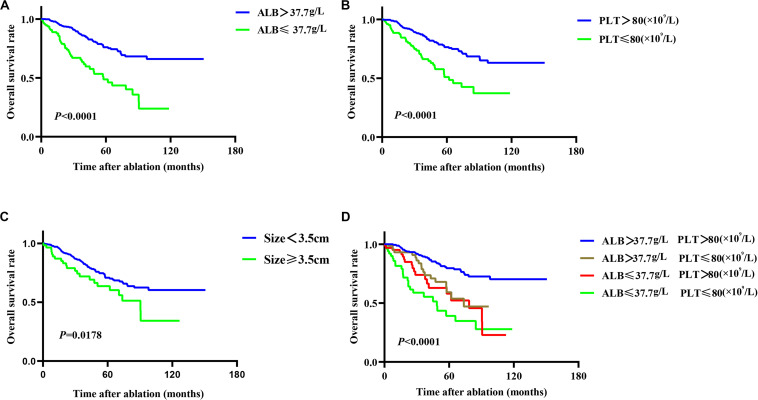
Kaplan–Meier plots for independent prognostic factors of overall survival (OS) in patients with HCC within the Milan Criteria after RFA. (A,B) Patients with reduced albumin (ALB) and platelet (PLT) level had lower OS rate than did those with higher ALB and PLT level. (C) Patients with tumor size ≥3.5 cm had lower OS rate than did those with size <3.5 cm. (D) Different combinations of ALB and PLT showed the different median OS, but the OS of the two combinations of (ALB > 37.7 g/L, PLT ≤ 80 × 109/L) and (ALB ≤ 37.7 g/L, PLT > 80 × 109/L) did not reach statistical difference (P = 0.397).